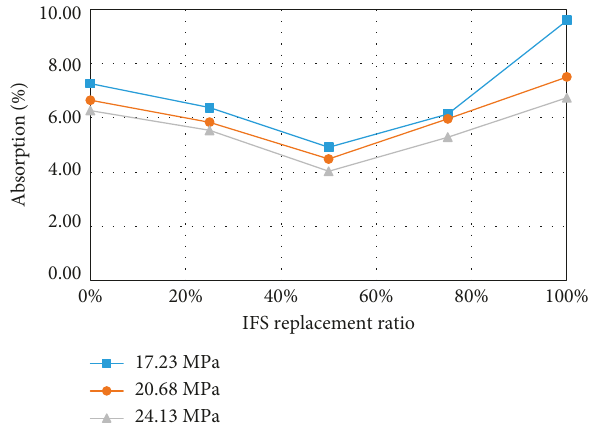
Figure 11: Absorption with respect to different IFS replacement ratio.